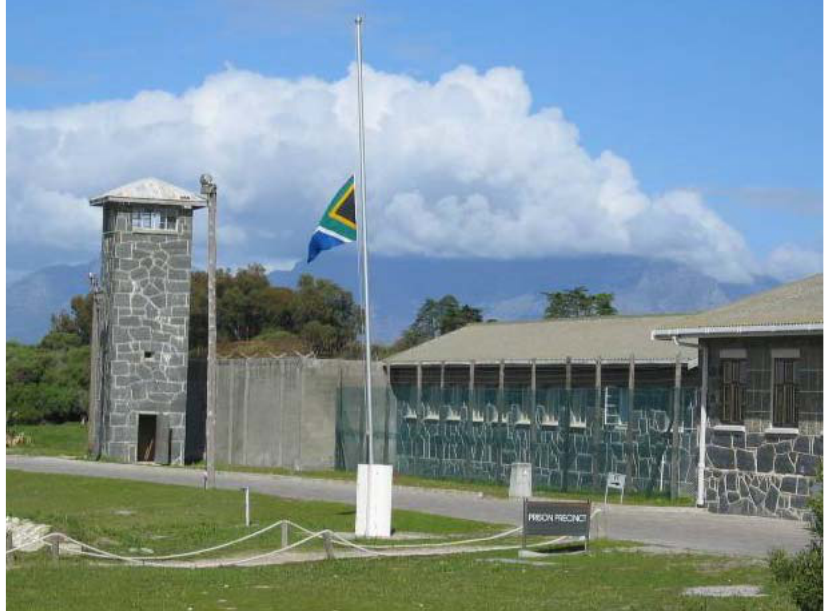
Figure 7. View of B Block where Nelson Mandela was imprisoned on Robben Island, Cape Town (author’s